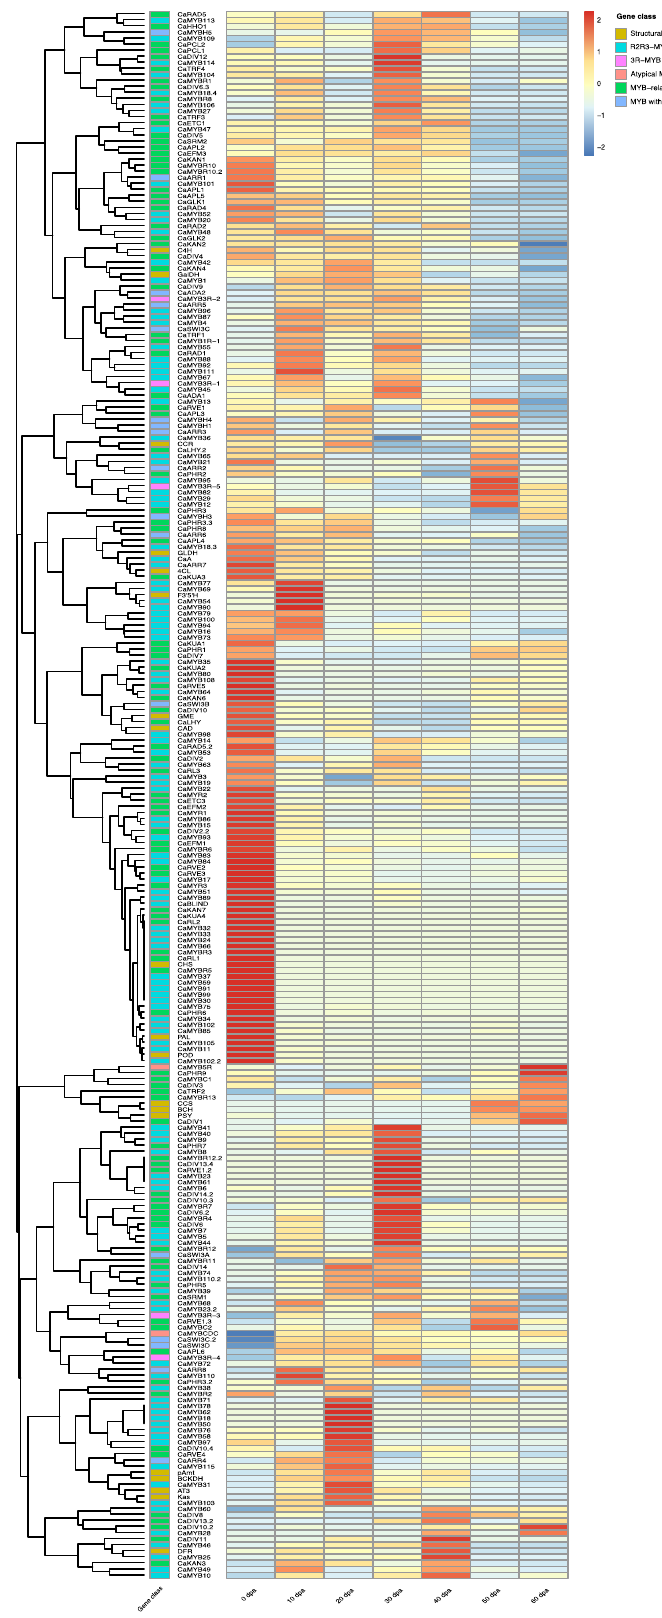
Figure 6. Expression profiles of CaMYB genes in flowers and during chili pepper fruit development. The heat map shows the expression pattern of CaMYB genes in flower (0 dpa; days